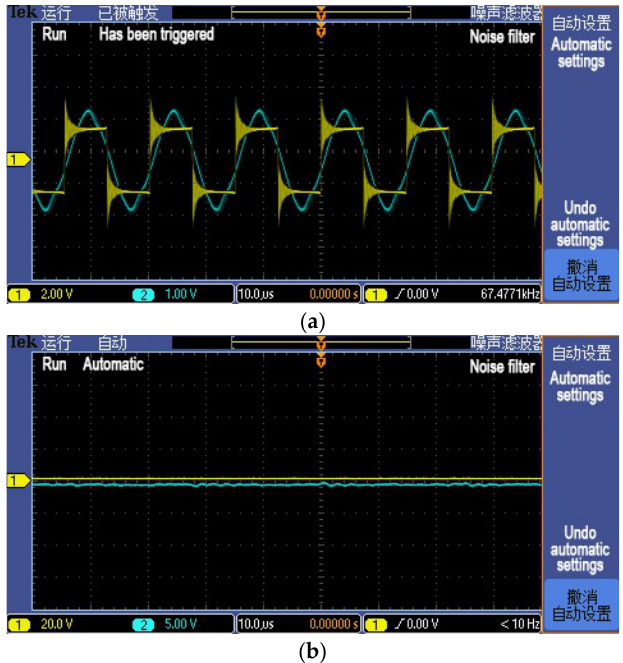
Figure 18. Sample value before and after the high-frequency inverter device under 12 cm distance without frequency adjustment. ( a ) High-frequency inverter device output voltage and primary coil current under 12 cm distance without frequency adjustment and ( b ) DC power output current under 12 cm distance without frequency adjustment.